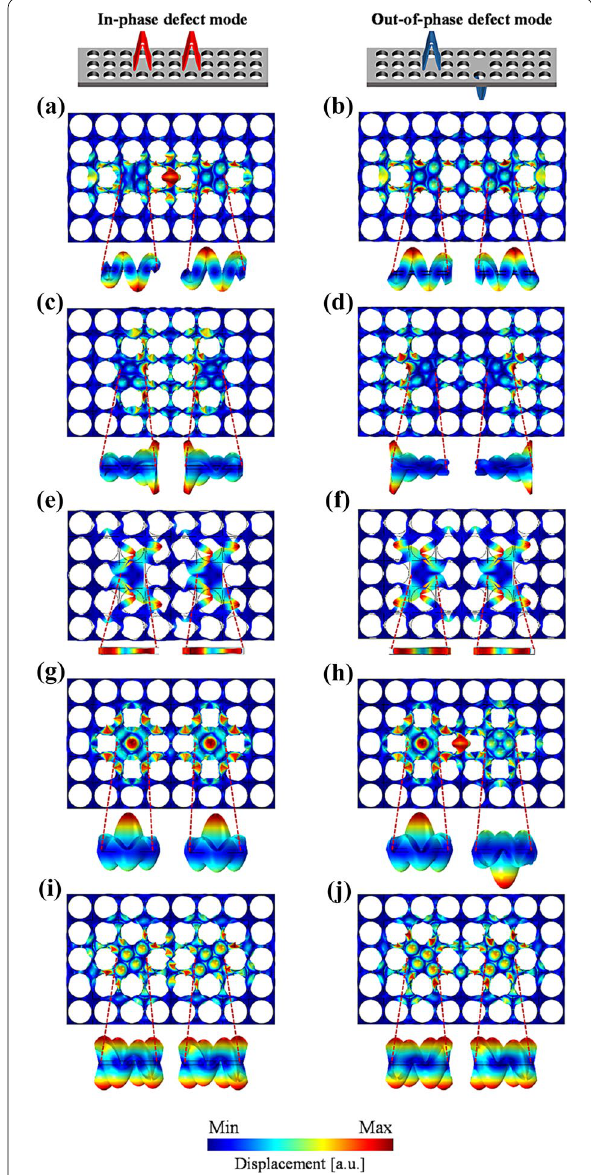
Fig. 2 In‑phase and out‑of‑phase defect mode shapes (out‑of‑plane displacement fields) for the phononic crystal with the double defects (4, 7) at defect band frequencies presented in Fig. 1(c): a 56.80